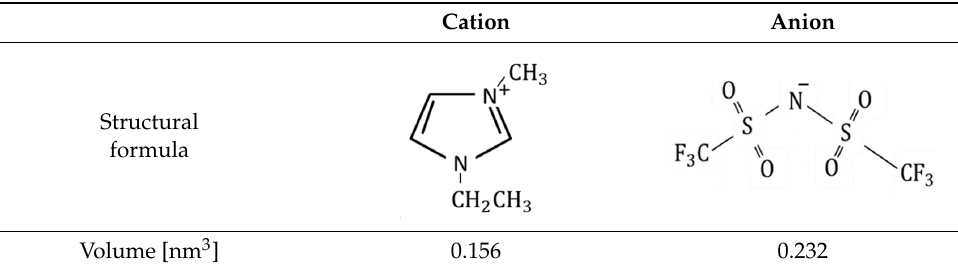
Table 3. Characteristics of ionic liquid, EMI-TFSI.